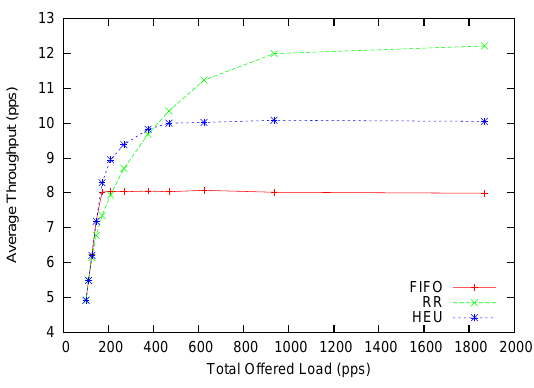
Figure 7. Average throughput performance with Poisson